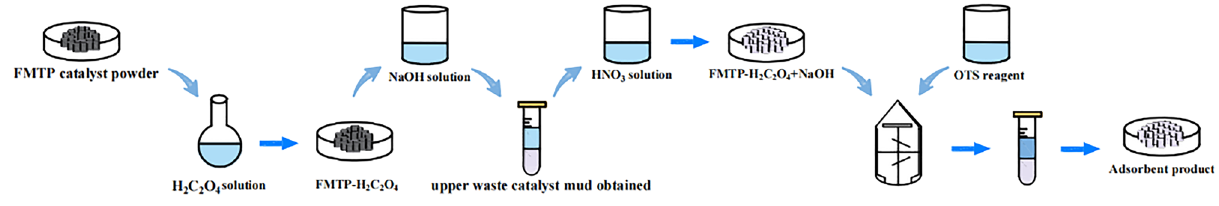
Figure 1. Flow chart of material